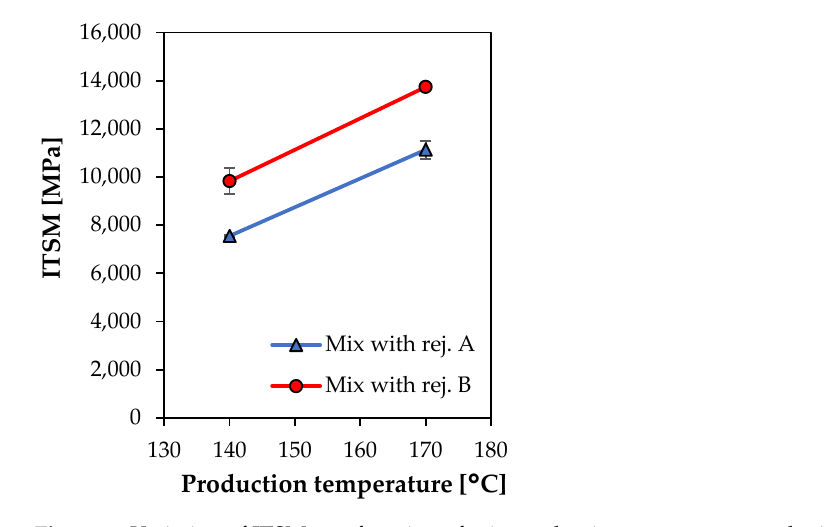
Figure 4. Variation of ITSM as a function of mix production temperature and rejuvenator type.